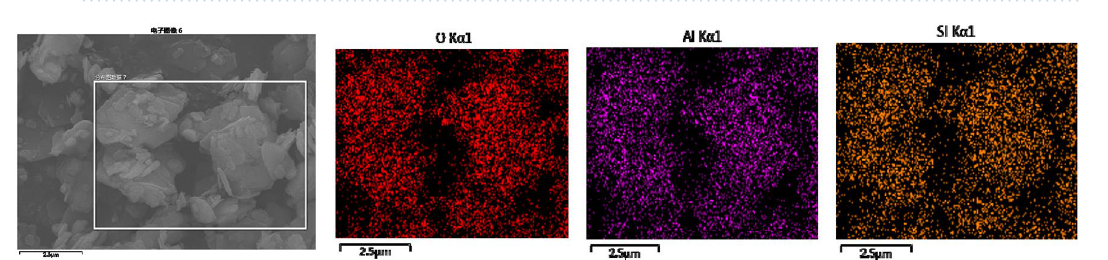
Figure 3. EDS scan of samples before adsorption of kaolinite.